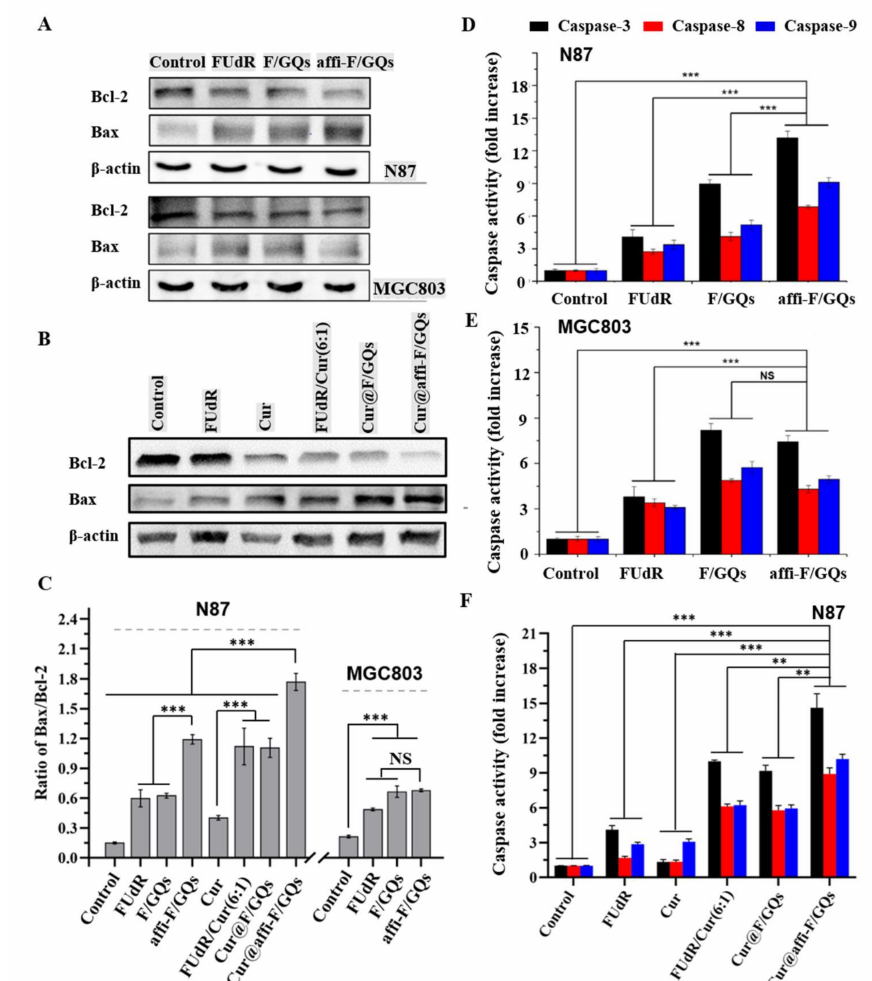
Figure 8. ( A ) Western blot of Bcl 2 and Bax in gastric cancer cells treated with free FUdR, F/GQs and affi-F/GQs, respectively. ( B ) Western blot of Bcl 2 and Bax in N87 cells treated with FUdR and Cur alone, FUdR/Cur (6:1) and Cur@affi-F/GQs, respectively. ( C ) Ratio of Bax/Bcl-2 in gastric cancer cells. ( D ) The activity of caspase 3, 8 and 9 in N87 cells treated with free FUdR, F/GQs and affi-F/GQs, respectively. ( E ) The activity of caspase 3, 8 and 9 in MGC 803 cells treated with free FUdR, F/GQs and affi-F/GQs, respectively. ( F ) The activity of caspase 3, 8 and 9 in N87 cells treated with FUdR and Cur alone, FUdR/Cur (6:1) and Cur@affi-F/GQs, respectively. (No significant difference (NS), ** p < 0.01 and *** p <